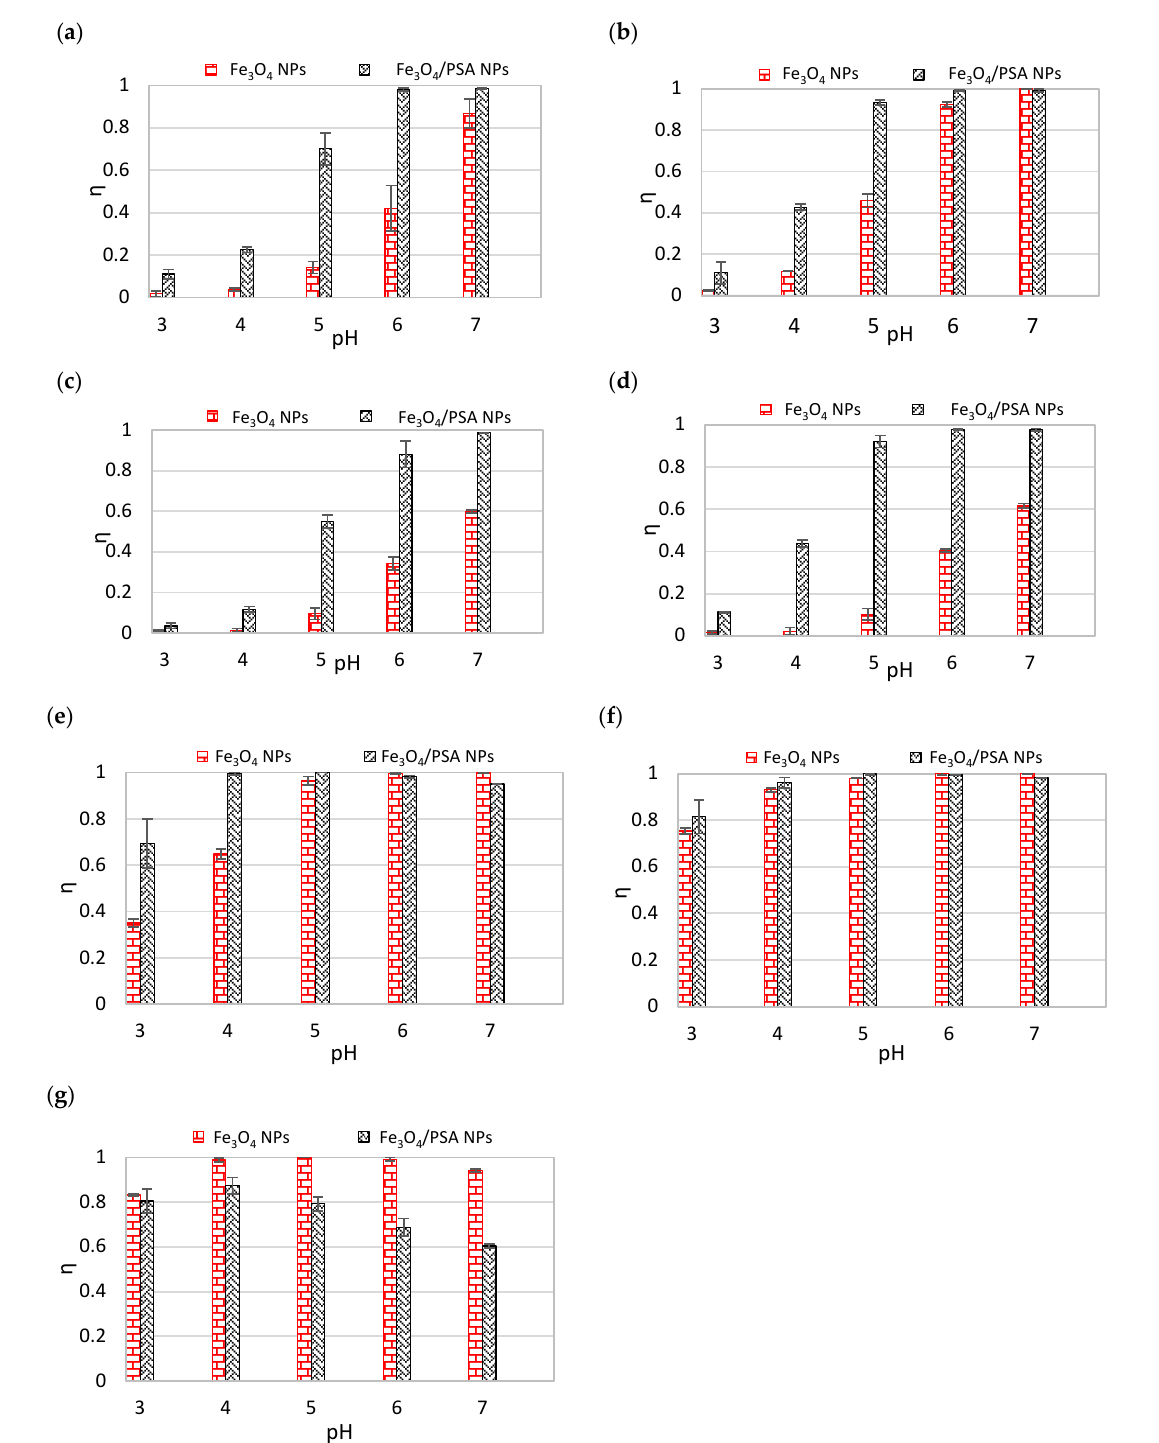
Figure 5. Effectiveness of unmodified magnetite (Fe 3 O 4 NPs) and modified magnetite (Fe 3 O 4 /PSA NPs), depending on the pH, toward individual heavy metals. ( a ) Zn(II), ( b ) Cu(II), ( c ) Ni(II), ( d ) Cd(II), ( e ) Pb(II), ( f ) Cr(III), ( g ) Cr(VI).